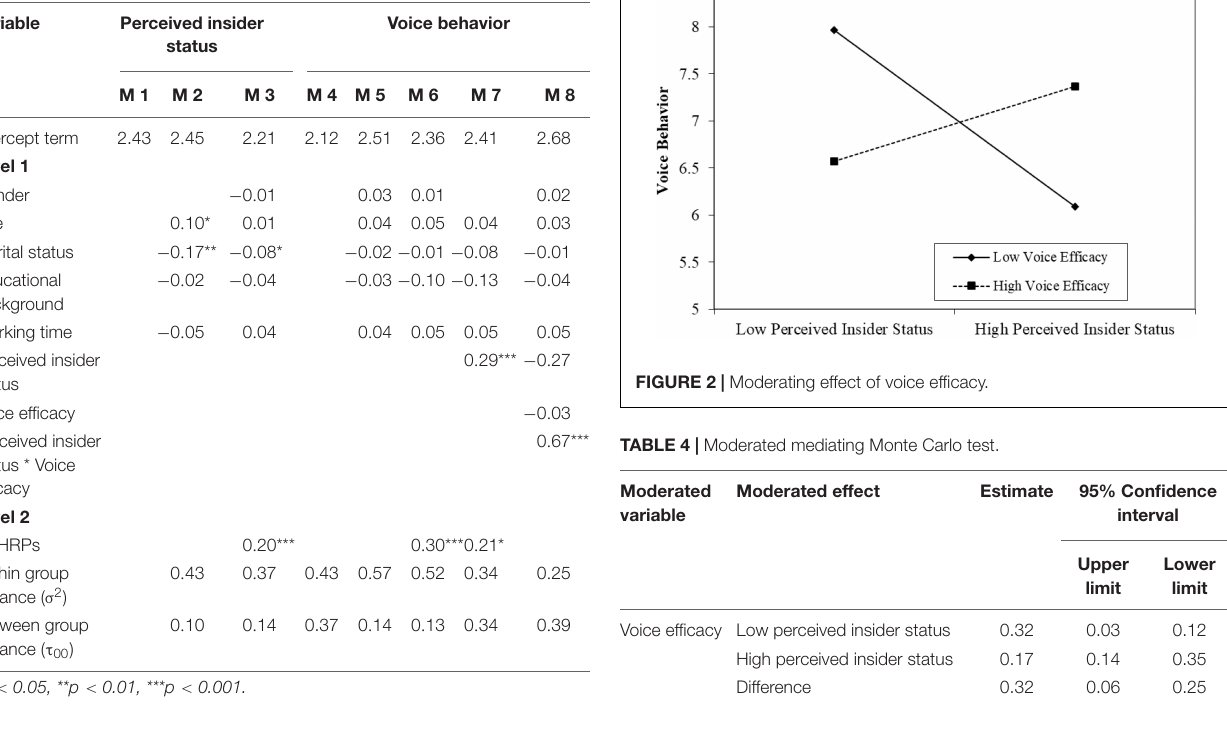
TABLE 3 | Multilevel analysis results.